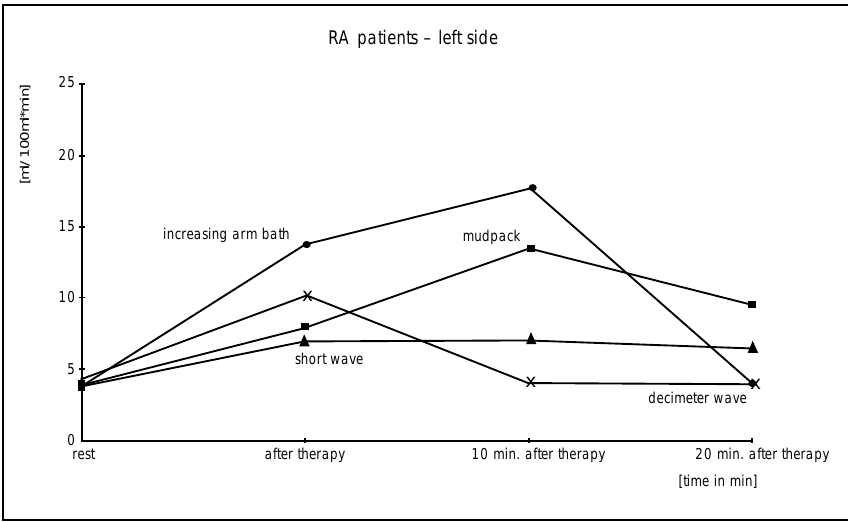
Figure 3: Consensual blood flow reaction in the contralateral forearm after the individual thermotherapies in the patient groups (n = 20).